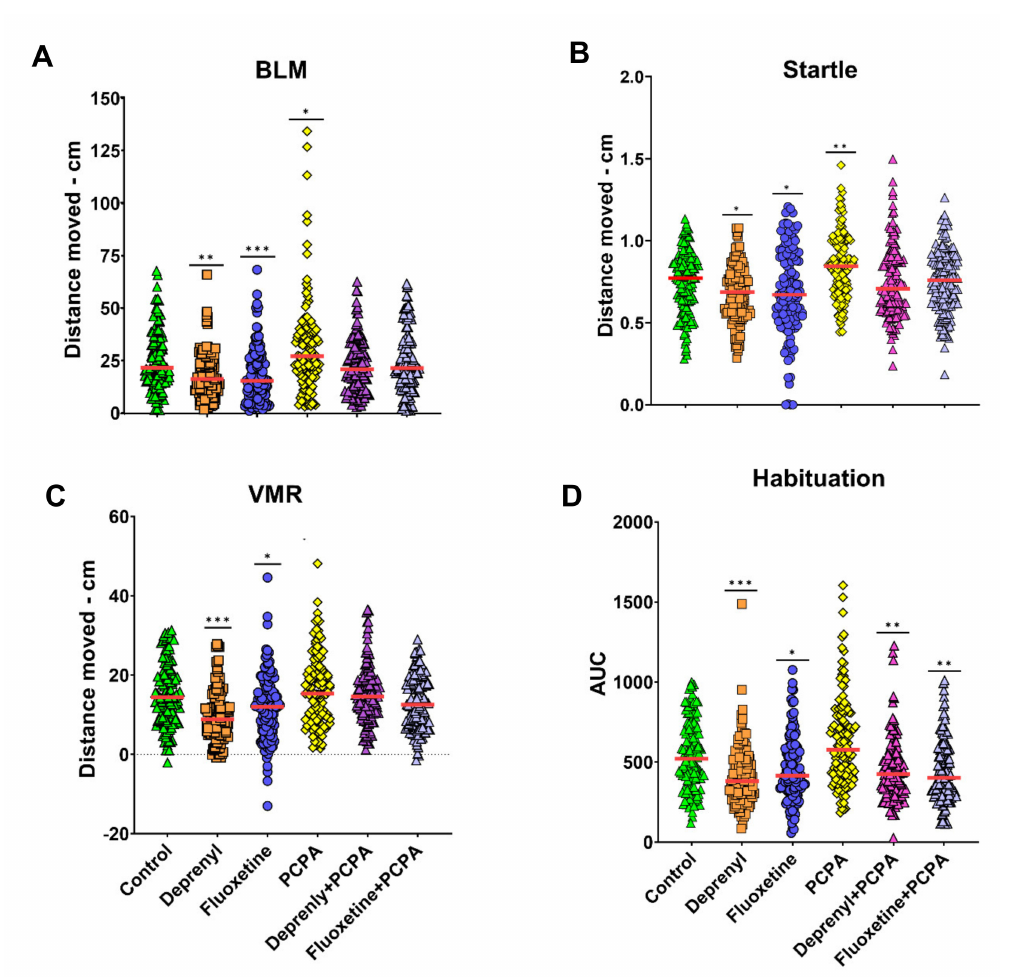
Figure 2. Behavioral changes on zebrafish 8 dpf old larvae, following 24 h waterborne exposure to 5 µ M Deprenyl, 0.5 µ M Fluoxetine, 2.5 mM PCPA, and the combination of 2.5 mM PCPA with either Deprenyl 5 µ M or Fluoxetine 0.5 µ M. ( A ) Basal locomotor (BLM) activity, represented as the total distance (cm) travelled during 10 min ( n = 126–132); ( B ) acoustic/vibrational escape response (startle), represented as the total distance (cm) travelled following the delivery of a tapping stimulus ( n = 127–133); ( C ) visual-motor response (VMR), representing the response of larvae due to transition of light to dark, represented as the difference of the total distance (cm) travelled by larvae during two minutes after and before the transition of light to dark ( n = 121–126); ( D ) habituation of the acoustic/vibrational escape response evoked by a series of 50 tapping stimulus delivered every second represented as area under the curve (AUC) of larvae responses ( n = 124–132). Data are from 3 independent experiments and are reported as scatter plots with the median (red line). Significance was set to p < 0.05 and can be represented as * when p < 0.05; ** when p < 0.01 and *** when p < 0.001, Kruskal–Wallis non-parametric